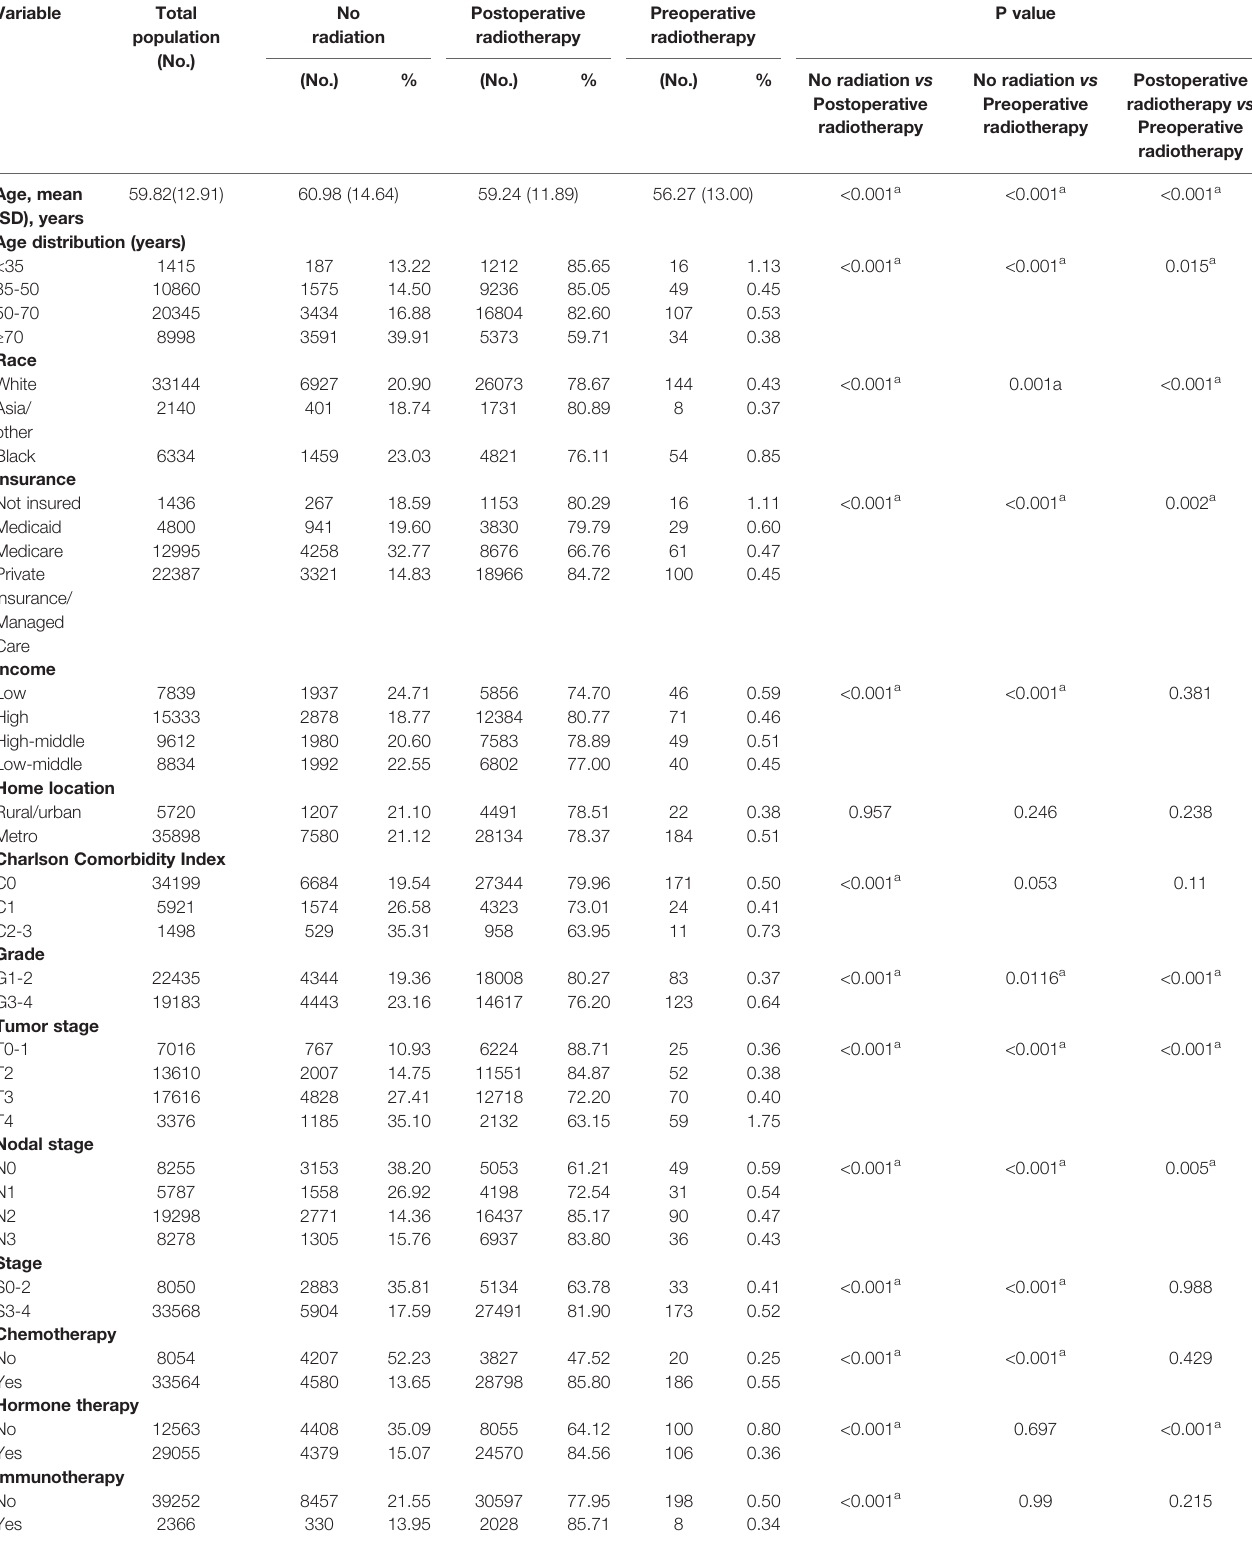
TABLE 1 | Patient demographic, disease, and treatment characteristics of locally advanced breast cancer grouped by radiation status. Variable Total